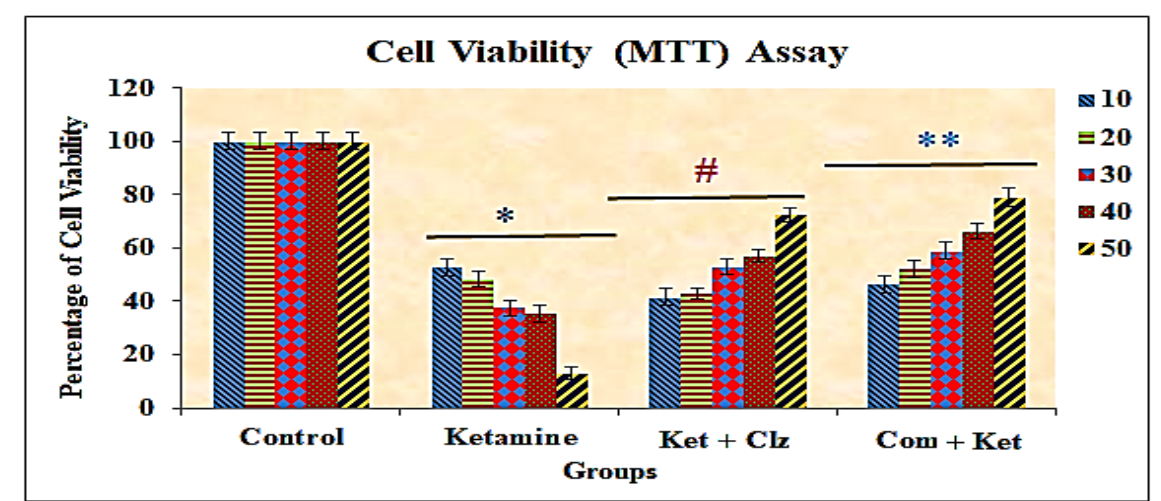
Figure 3. Alterations in cell viability in PC 12 cell lines exposed to ketamine and protective effects of plant compound and clozapine. All the values are expressed as means ± SD of six individuals. * Significant at p < 0.05 compared with control; # and ** significant at p < 0.05 compared with ketamine-treated group; 10 – 50: concentration in µg/mL of ketamine, clozapine, and compound.